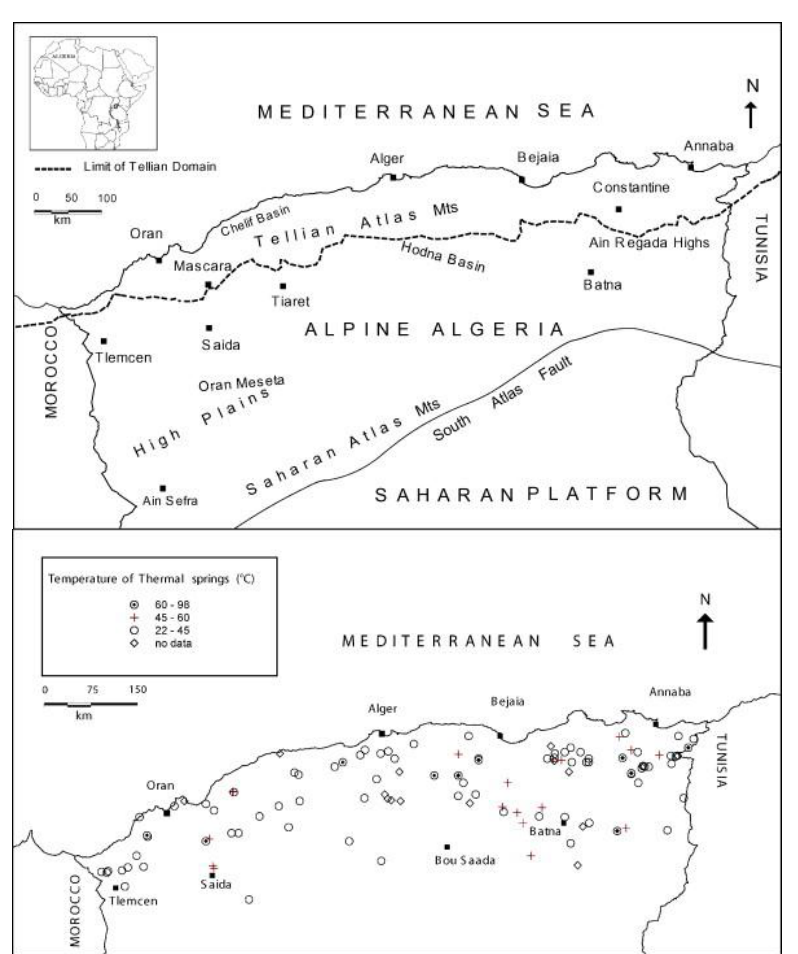
Figure 2. Top (a): Geological units of Northern Algeria [2,38]; Bottom (b): Main thermal springs in northern Algeria